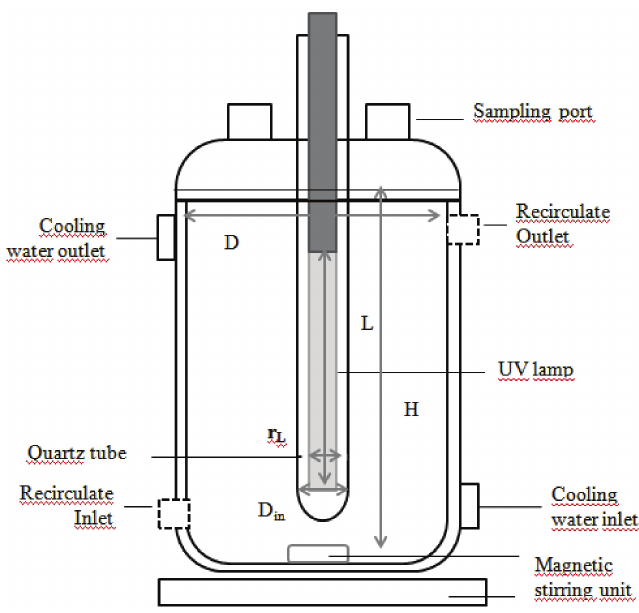
Fig. 1 – Schematics of cylindrical photoreactors